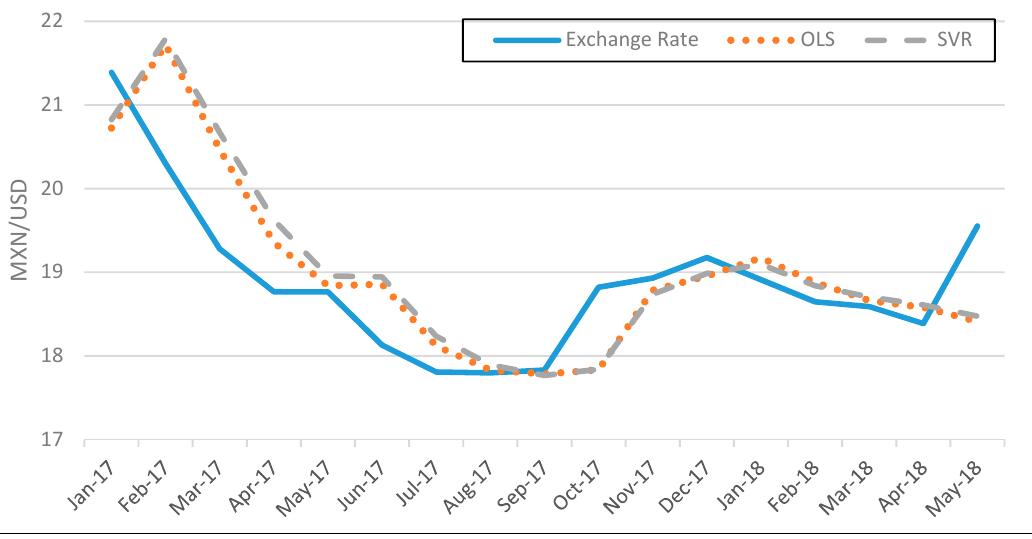
Figure 4. Out-of-sample 1-month ahead exchange rate forecasts for Mexico based on the GPR index for the SVR and OLS model for the period Jan-2017 to May-2018.